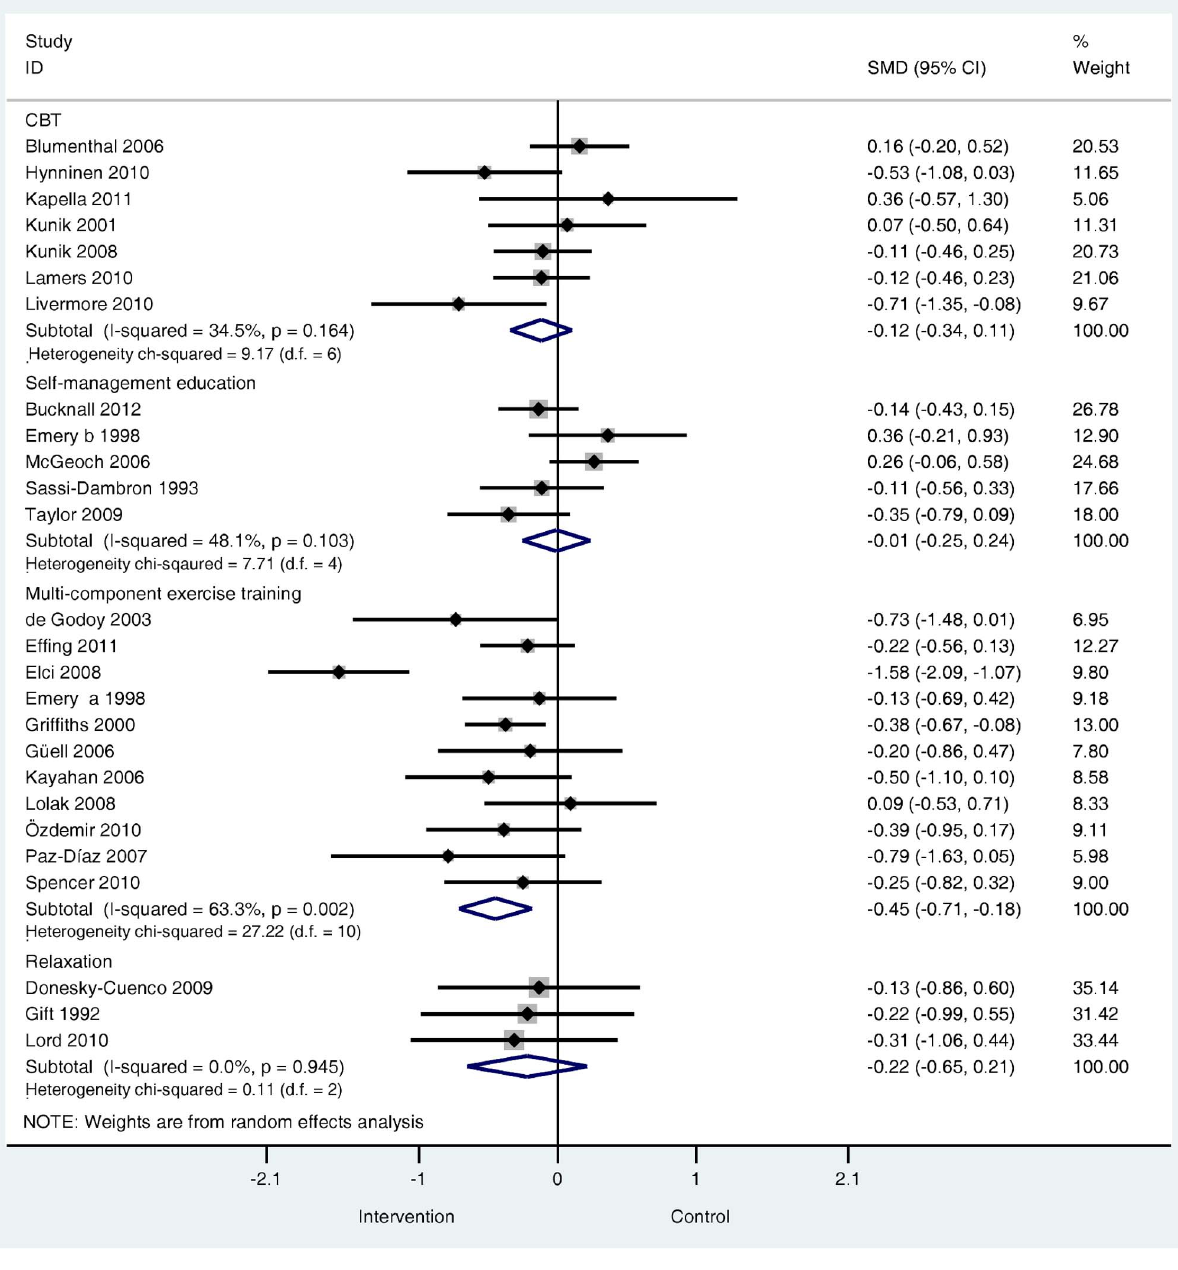
Figure 7. Effects of complex interventions by sub-group on self-reported symptoms of anxiety at post-treatment. Note: Random effects model used. 95% CI=95% confidence interval; SMD=standardised mean difference.